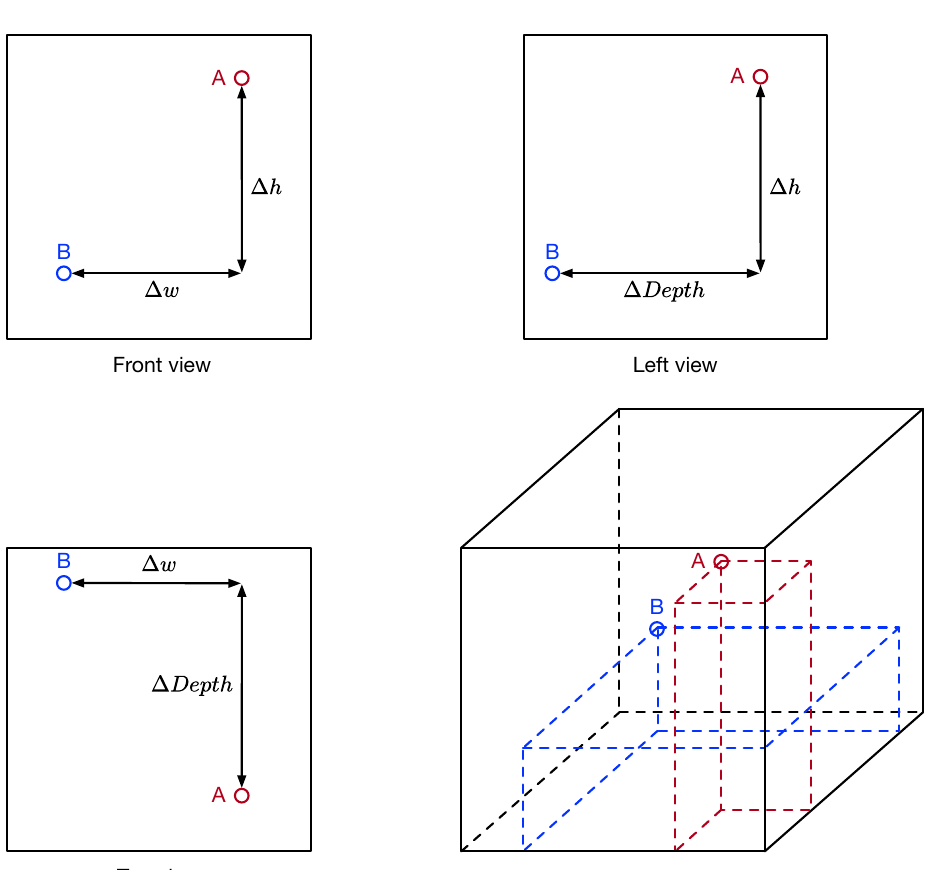
Figure 3. Multi-view images of two objects in 3D space. In the front view image, (cid:52) w and (cid:52) h can be calculated according to object center locations extracted by object detector. (cid:52) Depth is the difference of mean depth values between two detected bounding boxes. Note that (cid:52) w , (cid:52) h and (cid:52) depth in these three multi-view images have the same